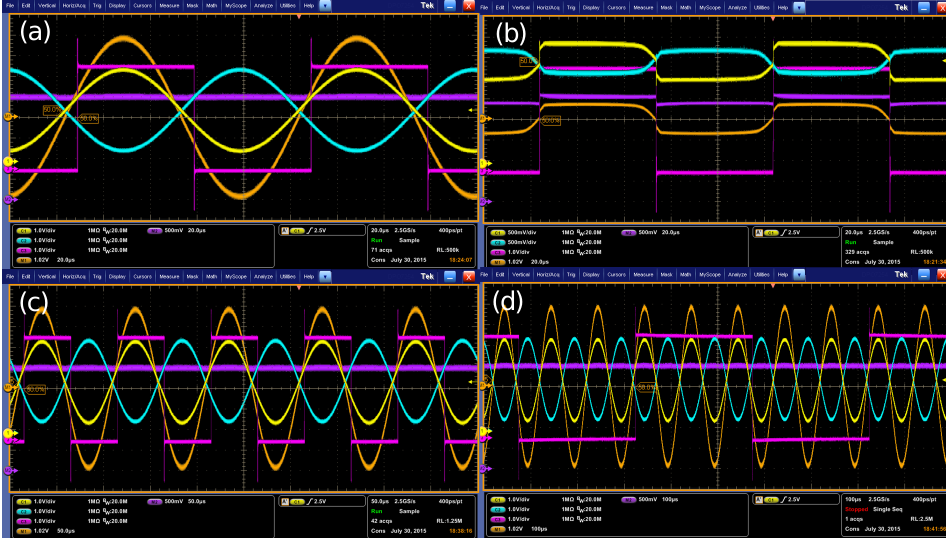
Figure 17. Readout circuit for inductive speed sensors: measured voltage waveforms. ( a ) Blind window disabled. Yellow and cyan traces: positive and negative input signals at IN Sp and IN Sn in Figure 9; orange and violet: differential and common-mode input signals; magenta: output signal of the readout circuit (i.e., at OUT ISS pin). ( b ) Yellow and cyan traces correspond here to the signals at the inputs IN p and IN n . ( c , d ) Blind window set to 6.4 µs and to 190 µs, with signals and colors of ( a